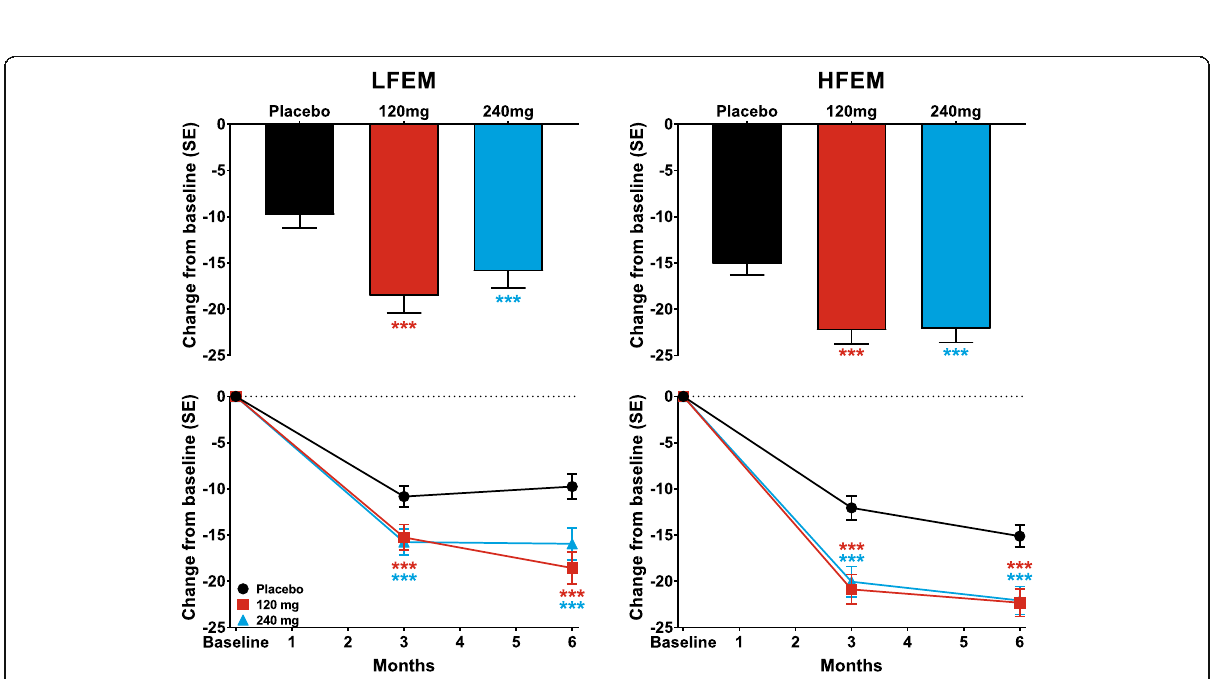
Fig. 7 The overall least-squares (LS) mean change in Migraine Disability Assessment (MIDAS) total Score for the average of Months 3 and 6 is shown for patients with LFEM and HFEM receiving placebo, 120-mg, or 240-mg of galcanezumab in the upper row. The LS mean changes in MIDAS total score at Months 3 and 6 for patients receiving these treatments is shown in the bottom row for patients with LFEM and with HFEM. ***p ≤ .001, **p ≤ .01, *p ≤ .05 vs